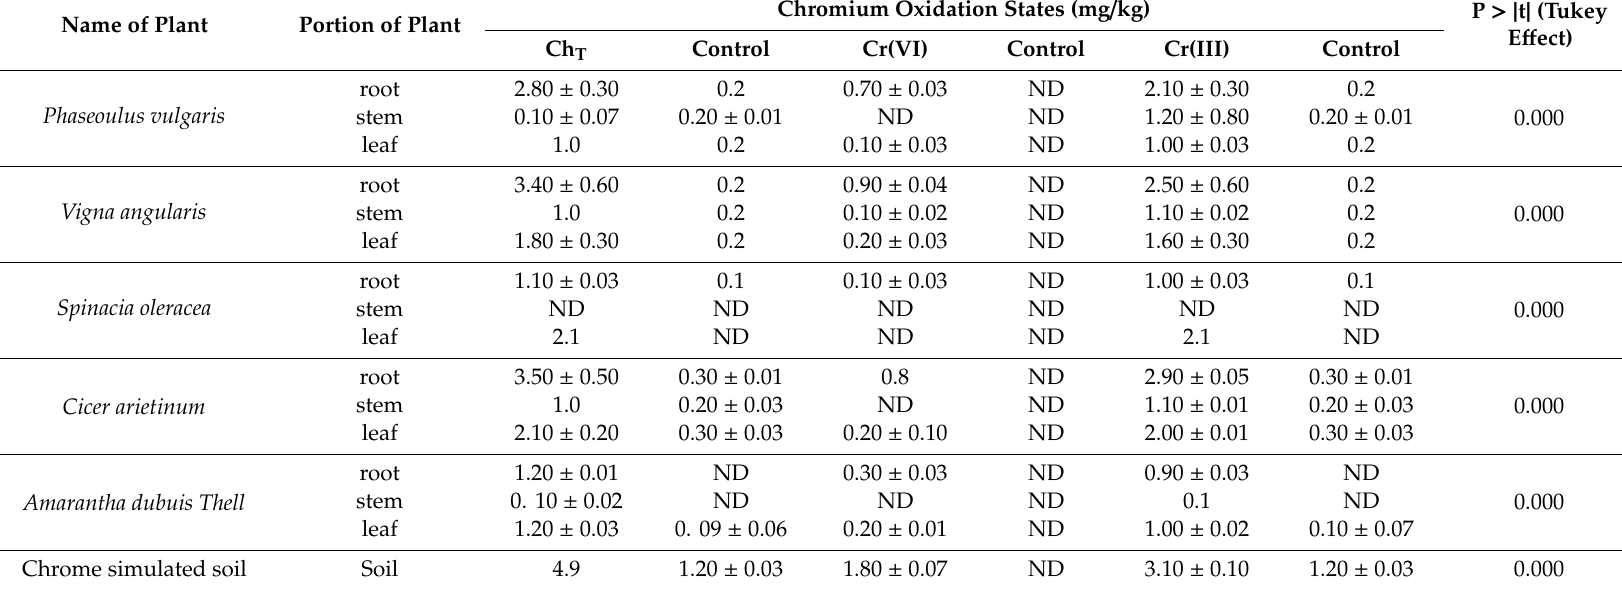
Table 3. The occurrence of Ch T , Cr(VI) and Cr(III) in root, stem and leaf of di ff erent plant species in the simulated soil. Experimental errors lower than 0.01 mg / kg have been